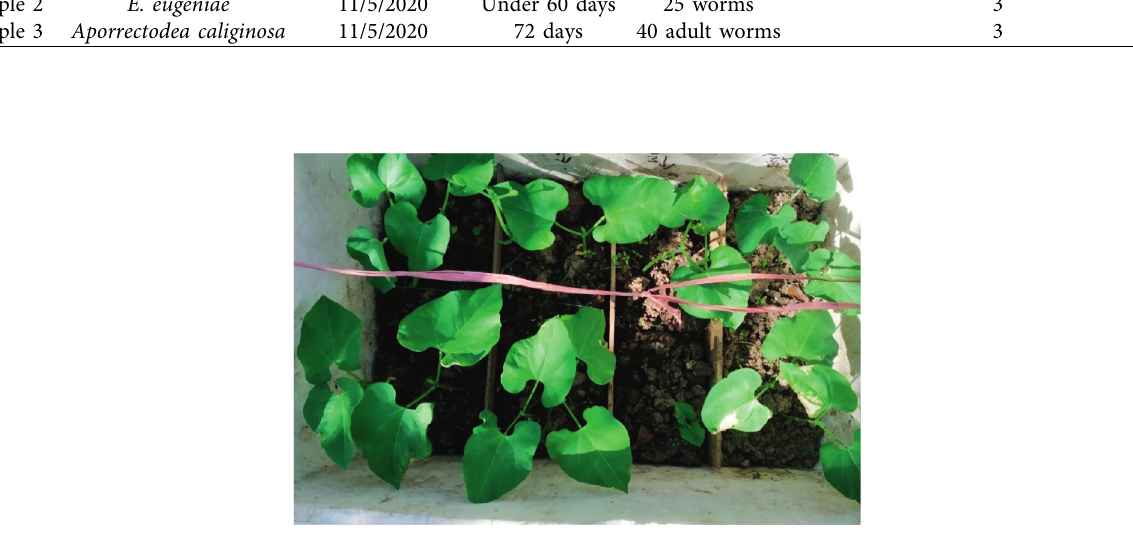
Figure 2: Phaseolus vulgaris ( mesh bean plants). Table 4: Application of vermicompost used in different replicates.